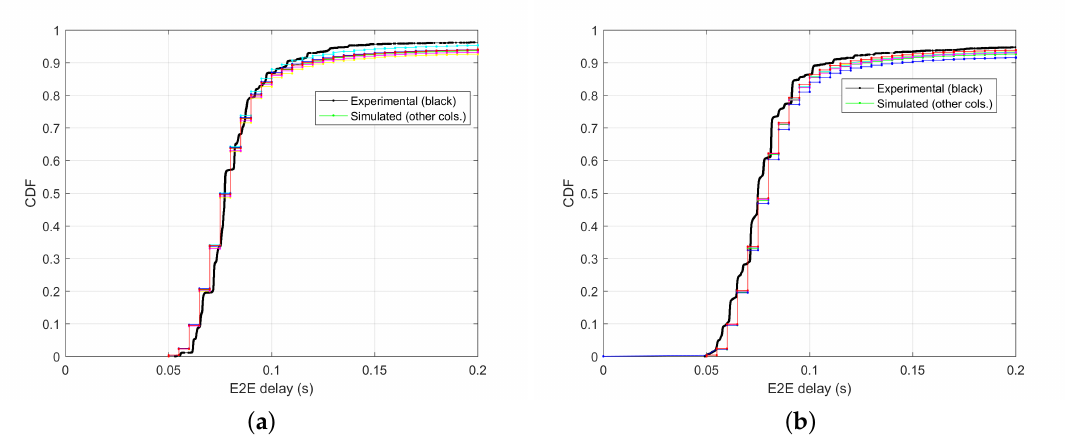
Figure 12. Comparison of E2E delay Cumulative Density Function generated from the model with the corresponding experimental Cumulative Density Function: Two different measured samples on the same railway section (WCDMA 2100 technology only).